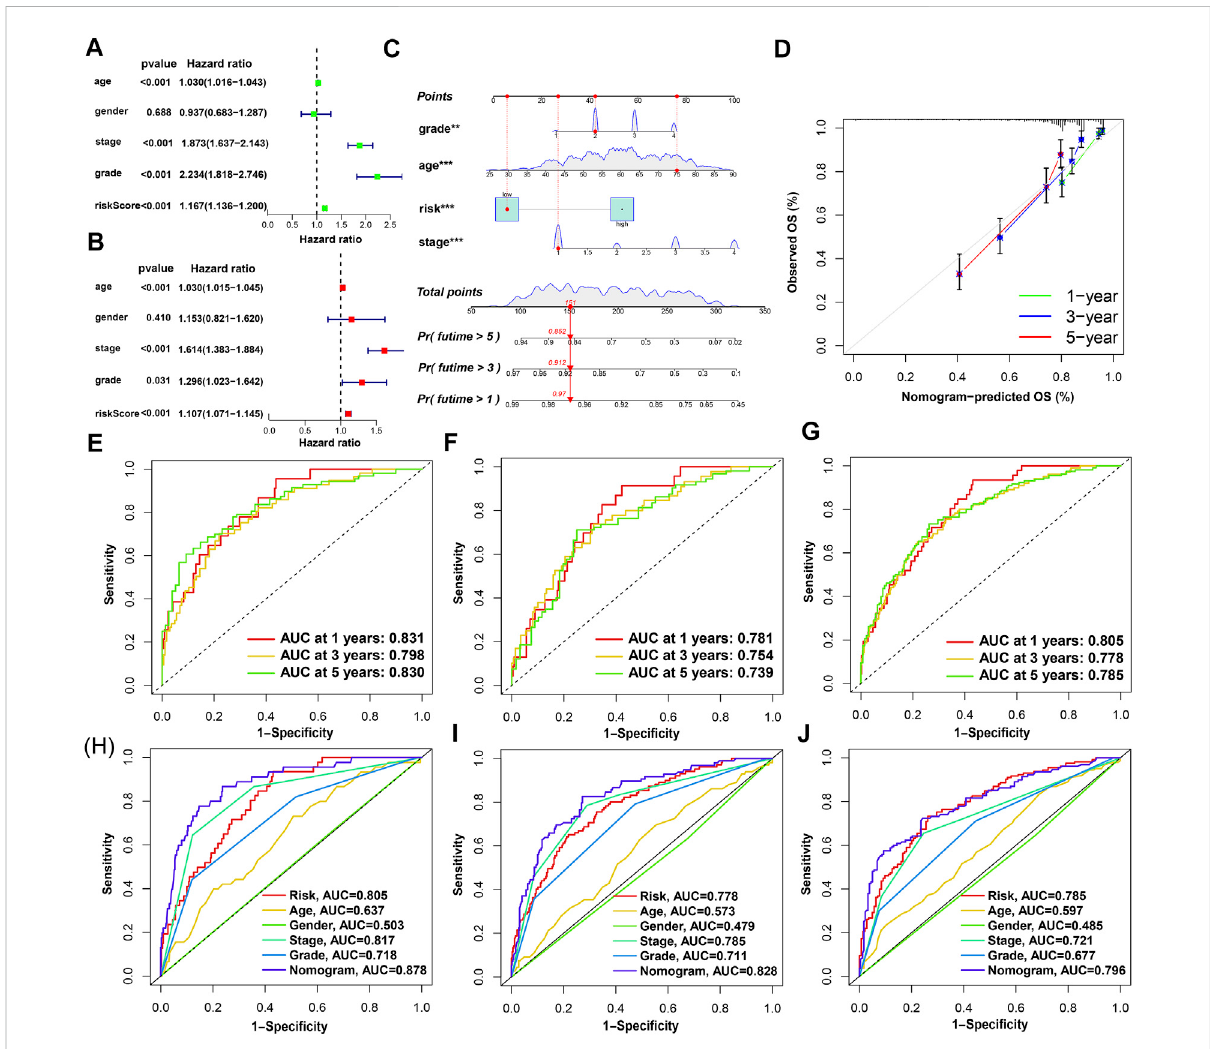
FIGURE 5 Nomogramandassessmentoftherisk-strati fi edmodel. (A,B) UnivariateCoxandmultivariateCoxregressionanalysesofclinicalfactorsandrisk score with OS, respectively; (C) the probability of the 1-, 3-, and 5-year OS predicted by the nomogram which integrated the risk score, age, tumor grade, andtumor stage; (D) thecalibrationcurves for 1-, 3-, and5-year OS; (E – G) the1-,3-, and 5-year ROC curves of thetrain,test, and entire sets, respectively; (H – J) the 1-, 3-, and 5-year ROC curves of risk score, nomogram score, and clinical